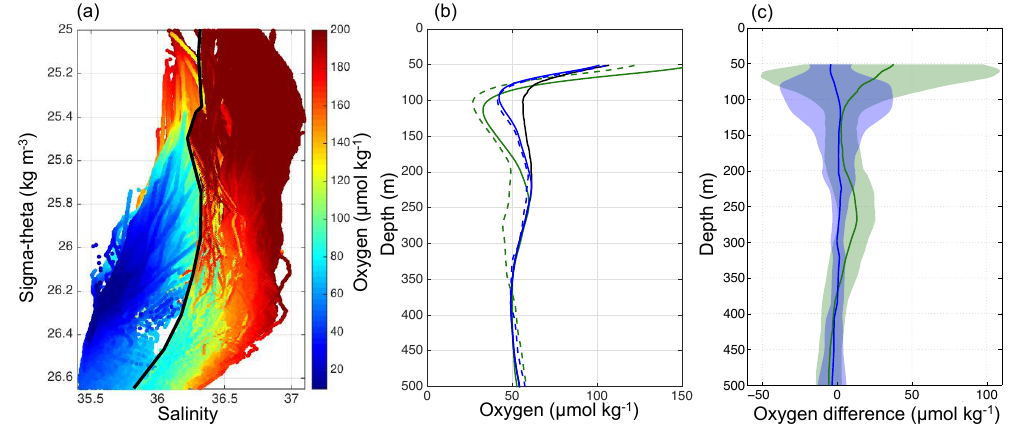
Figure 3. (a) Salinity– σ θ diagram with color indicating the oxygen concentrations. The black line separates the 173 profiles with minimum oxygen concentration of <40µmolkg − 1 (left side/more SACW characteristics) from profiles of the surrounding water (right side/more NACW characteristics), taken from the same devices shortly before and after the encounter with a low-oxygen eddy. (b) Mean oxygen concentration vs. depth of the coastal region (east of 18 ◦ W, solid black line), of all CEs (solid blue line) and all ACMEs (solid green line) with available oxygen measurements. The dashed line represents the reconstructed mean oxygen concentration for the same CEs (blue) and ACMEs (green). (c) Difference between the reconstructed and measured oxygen concentrations in CEs (blue) and ACMEs (green) with associated standard deviation (shaded